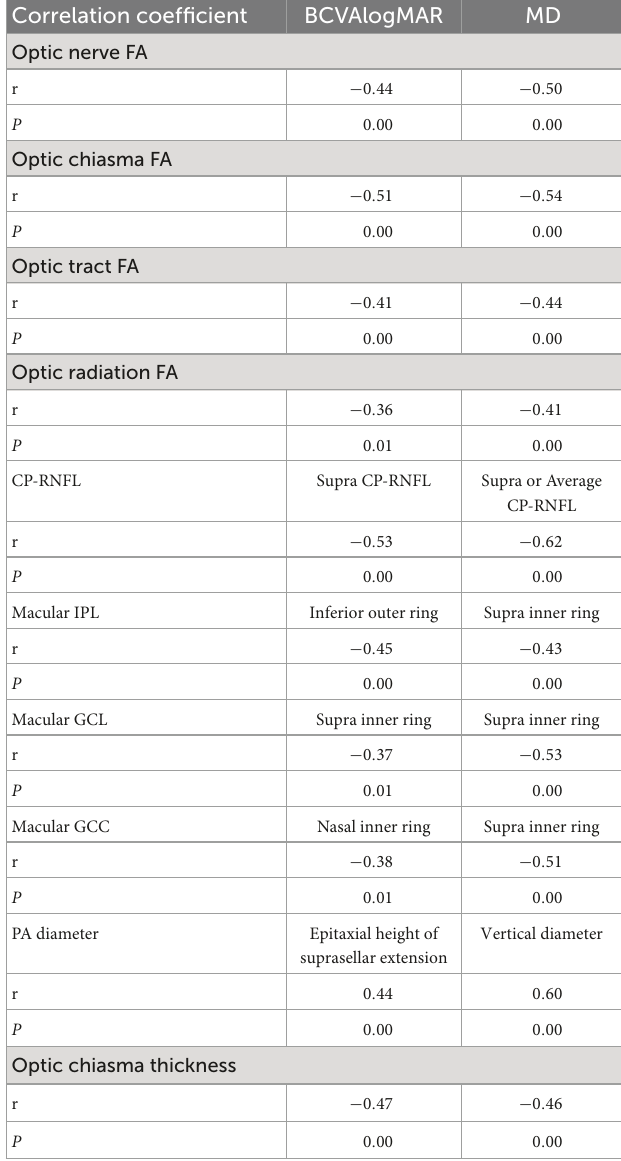
TABLE 5 Correlation analysis between BCVAlogMAR and MD and DTI parameters and OCT parameters. Correlation coefficient BCVAlogMAR